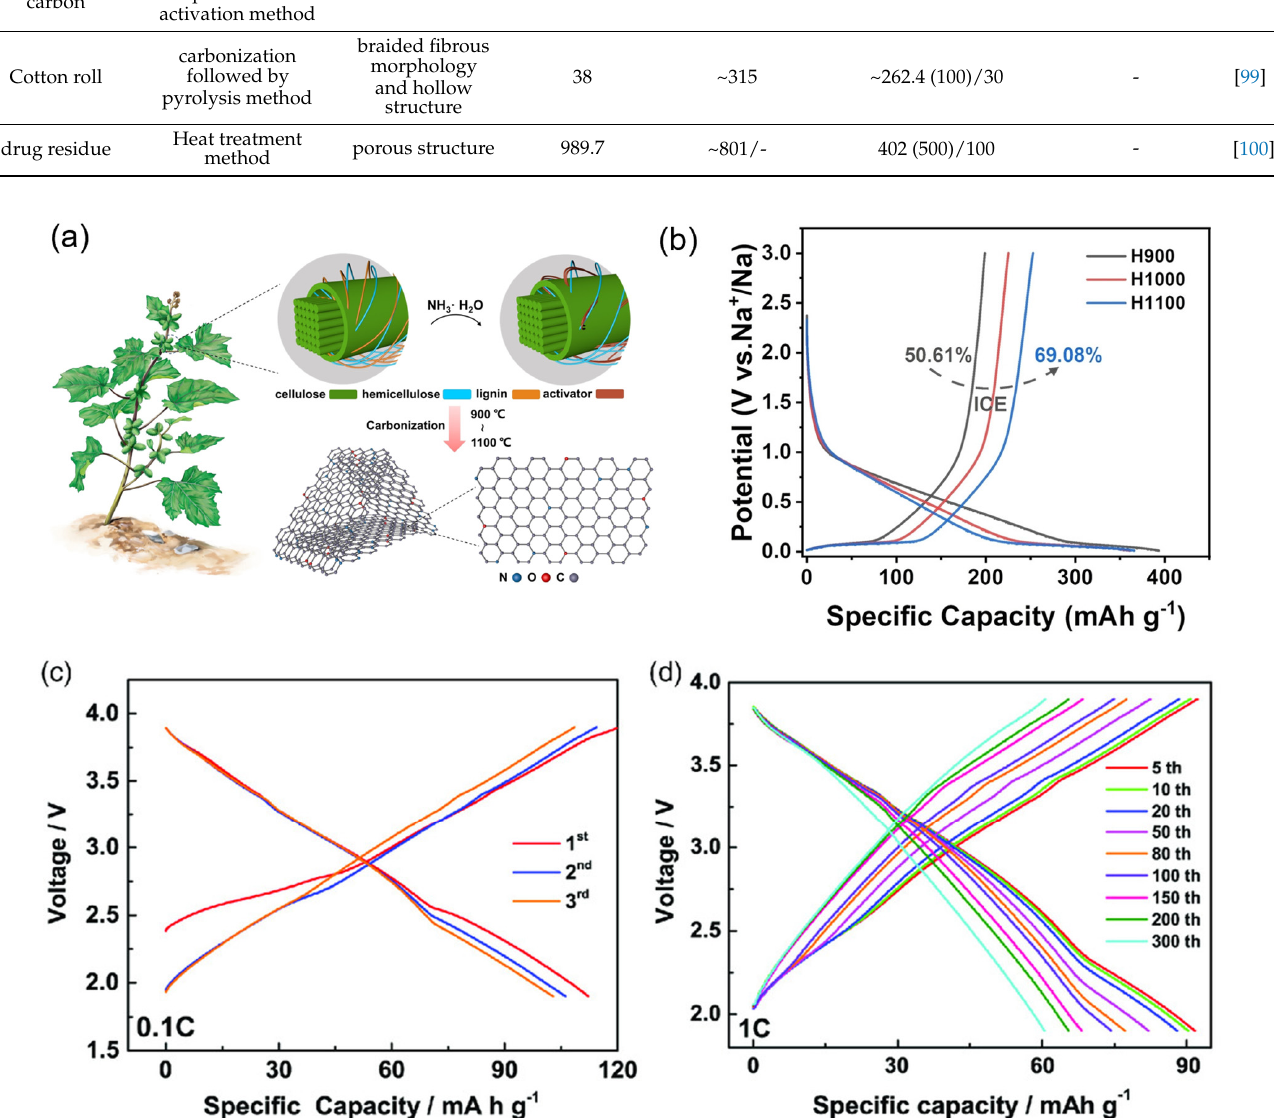
Figure 6. ( a ) The cocklebur fruit used as a biomass and synthesis of carbon anode materials for NIBs. ( b ) The electrochemical performance of first discharge and charge profiles for carbon materials with different synthesis temperatures (900, 1000, and 1100 °C). Reproduced from [93] with permission from Wiley. ( c , d ) The first three cycles of O 3 -Na[Li 0.05 Ni 0.3 Mn 0.5 Cu 0.1 Mg 0.05 ]O 2 (NaLNMCM) as a cathode and hard carbon biomass as an anode, with a rate of 0.1 C and cycling profiles versus specific capacity for the intermediate cycles with the constant current rate of 1 C. Reproduced from [10] with permission from Wiley. Table 2. Comparative electrochemical performance of biomass-based carbon material anodes for NIBs.